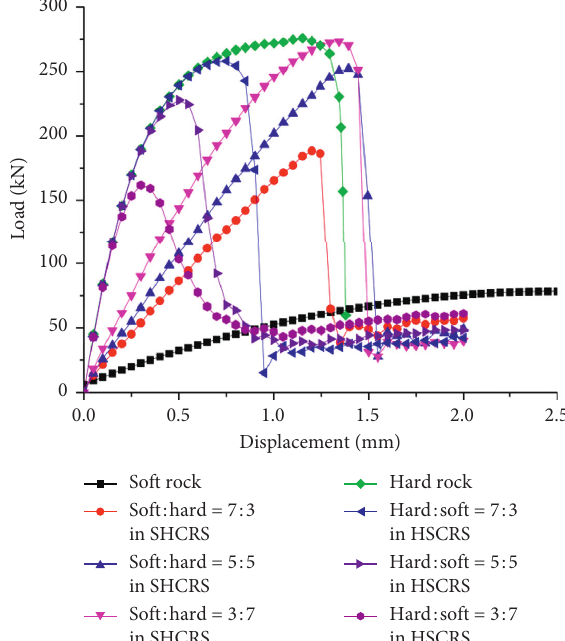
Figure 18: Load-displacement comparison curves under different soft and hard composite rock strata.